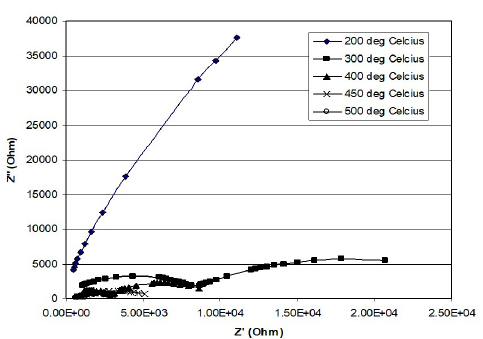
Figure 8. Complex impedance measured at 200,300,400,450 and 500 0 C in air of CSZ specimen containing 12 mol% CaO.